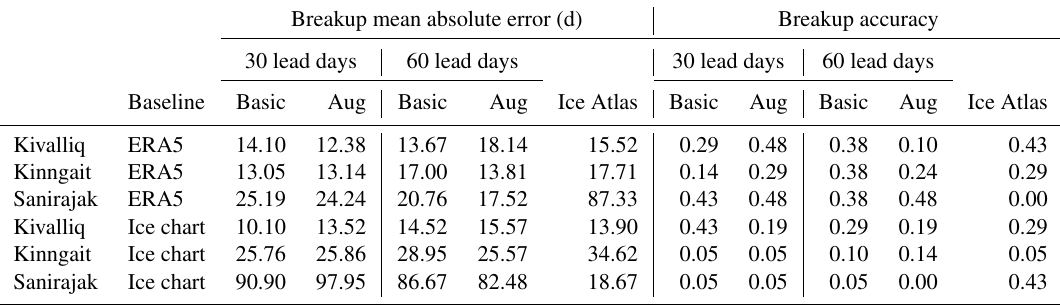
Table 1. Breakup mean absolute error and accuracy at selected sites using data from the CIS Ice Atlas, Basic, and Augmented (Aug) models at 30 and 60 lead days versus baseline observations derived from CIS regional ice charts and ERA5.